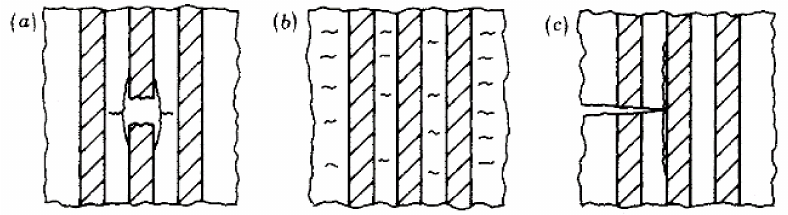
Figure 4. Fatigue damage mechanisms in UD composites under loading parallel to the fibre direction: ( a ) fibre breakage/interfacial debonding; ( b ) matrix cracking; ( c ) interfacial shear failure, reprinted with permission from ref. [20]. Copyright 1981 The Royal